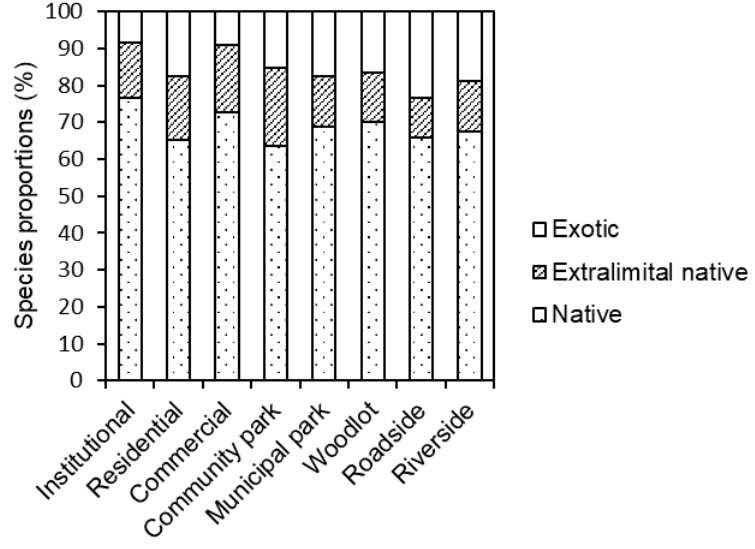
Figure 3. Ruderal species origins in the eight LUTs in the built-up areas of Beijing.